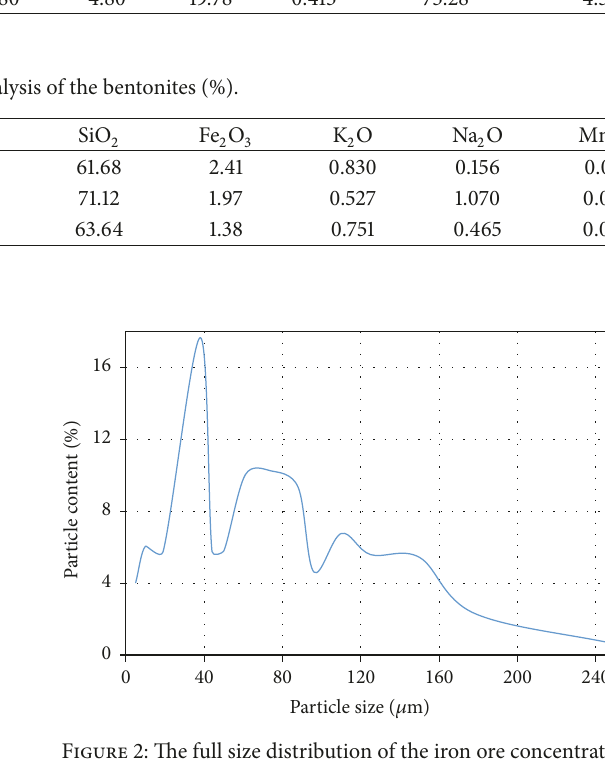
Figure 2: The full size distribution of the iron ore